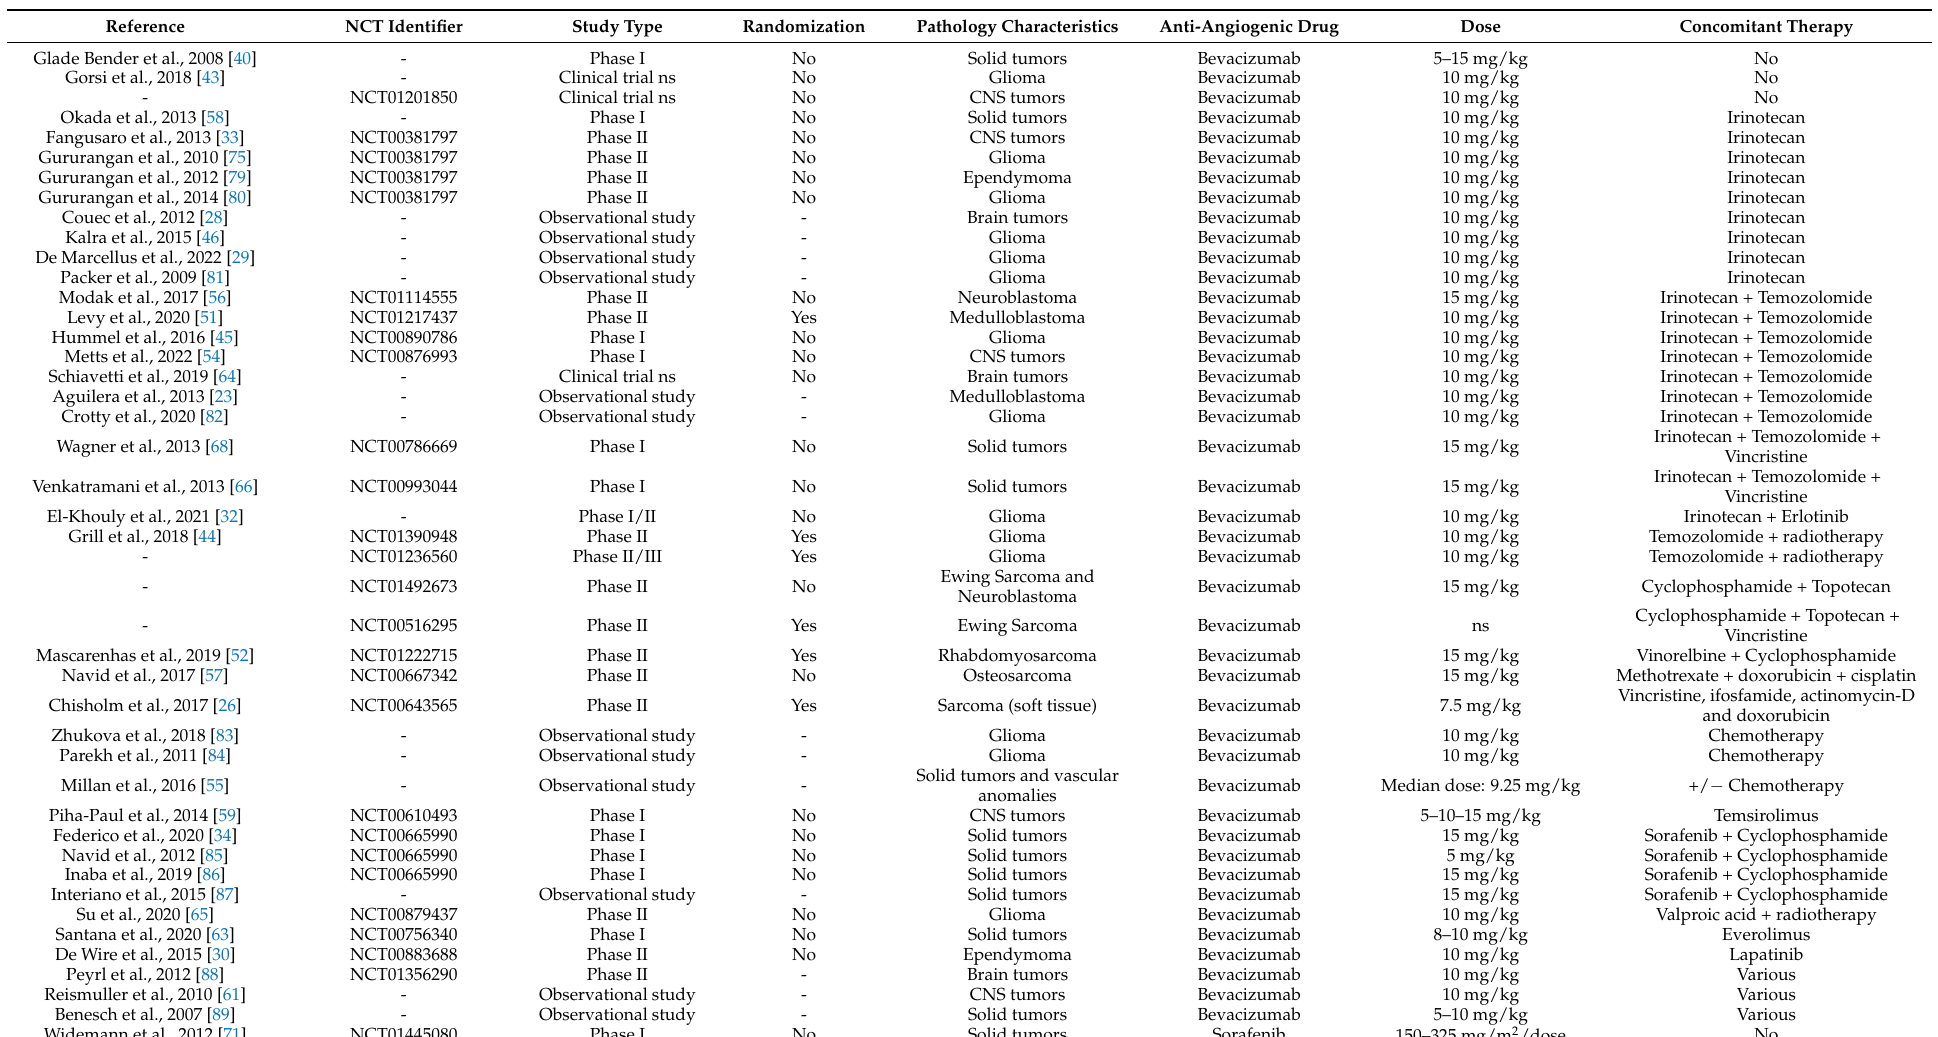
Table 2. Characteristics of included studies assessing safety of anti-angiogenic drugs in pediatric patients with solid